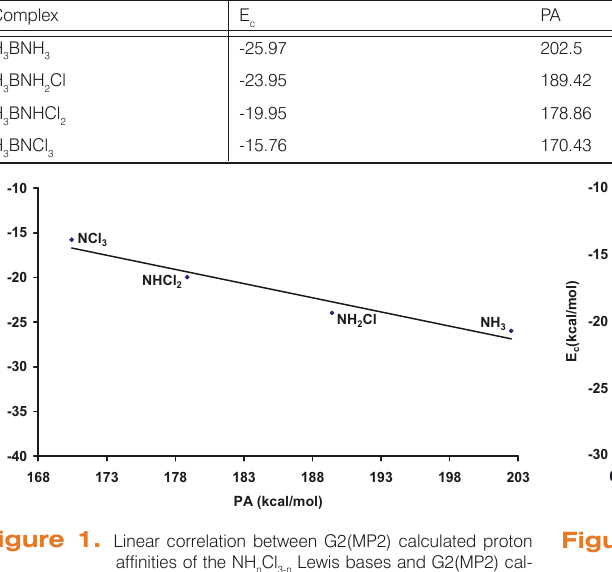
affinities of the NH culated complexation energies of H complexes.